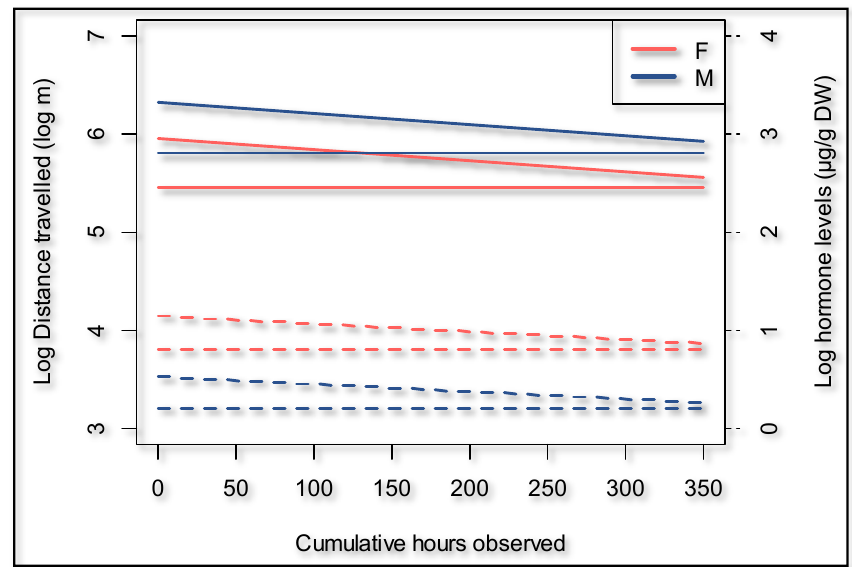
Figure 4. Giraffe habituation shown as distance walked as well as fecal glucocorticoid metabolite concentrations over time. Dotted lines are the hormone levels, straight lines are the distances trav- elled.